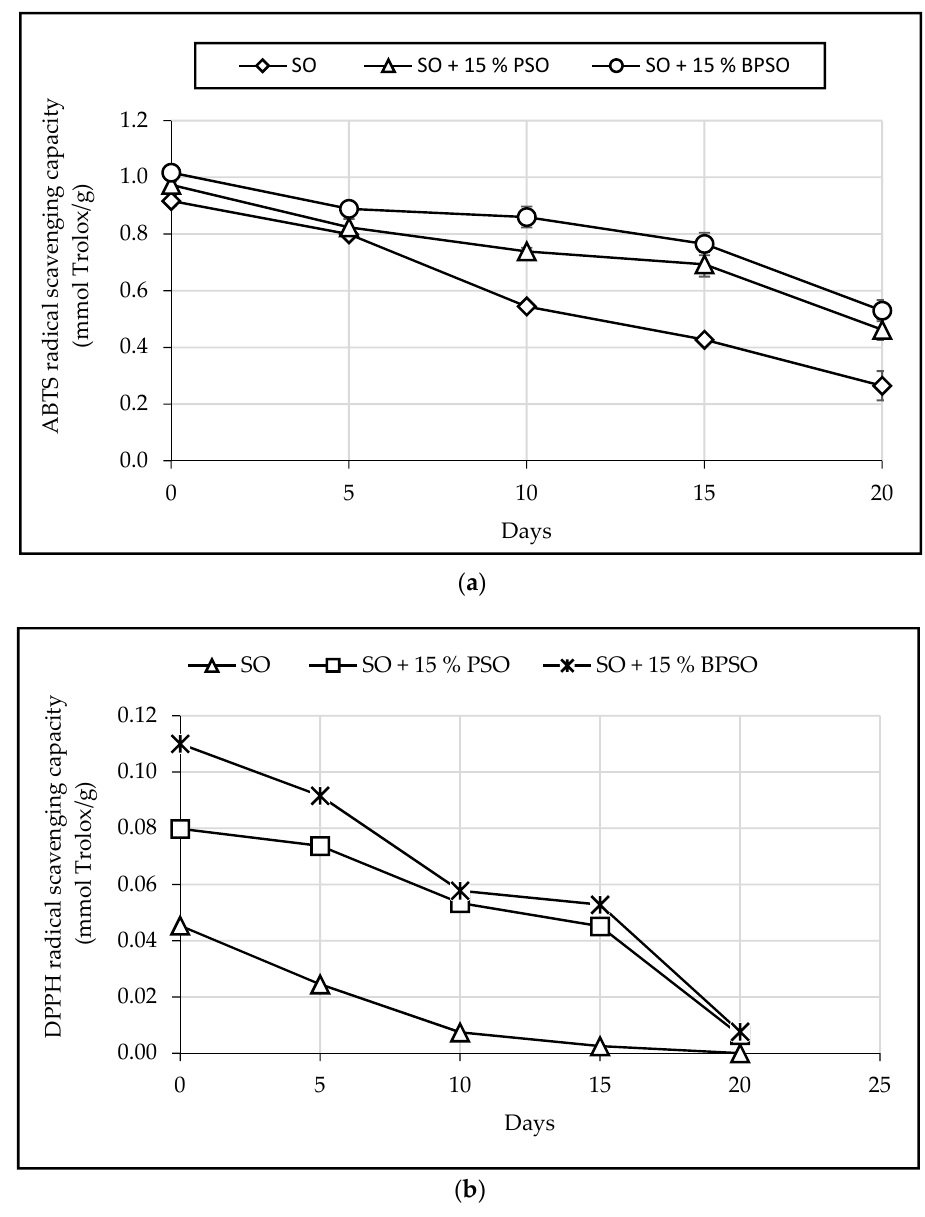
Figure 3. Changes in ( a ) ABTS and ( b ) DPPH radical scavenging capacity of SO and oil blends (85:15 w / w ) during accelerated storage. Values given are the mean of three replicates. SO—sunflower oil, PSO—pomegranate seed oil from unblanched seeds, BPSO—pomegranate seed oil from blanched seeds, DPPH—2. 2-diphenyl-1-picryl hydrazyl, ABTS—2, 2'-azinobis(3-ethylbenzothiazoline-6-sulfonic acid).